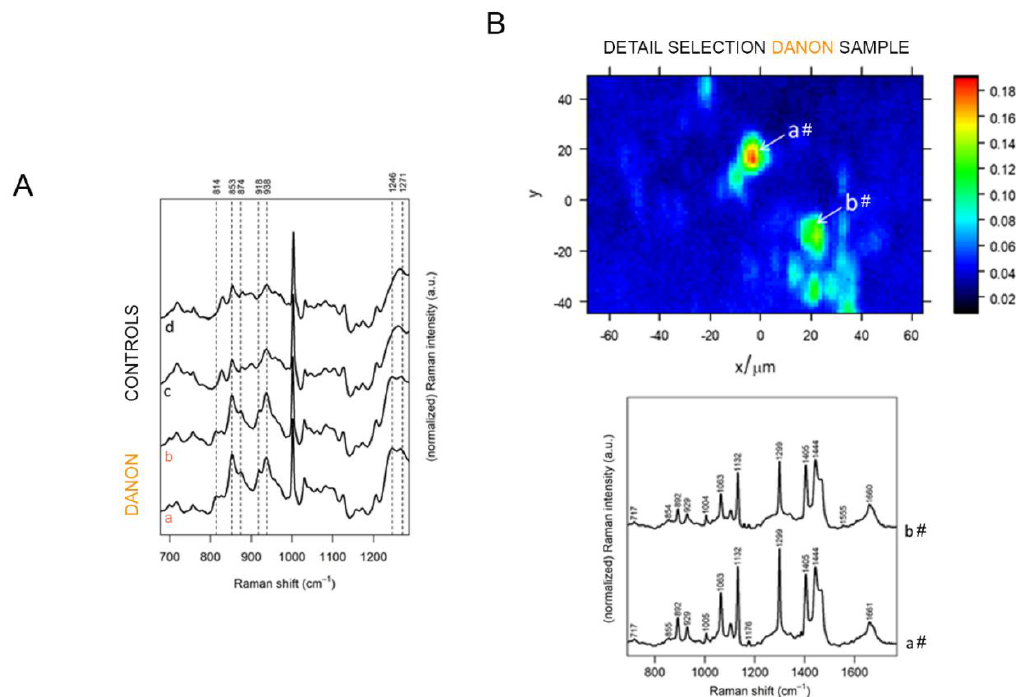
Figure 5. Structural characterization of cardiac tissue. ( A ) Average Raman spectra from tissue sections collected from two Danon patients (a, b, orange) and two controls (c, d, black). The Raman shifts of characteristic collagen bands are shown. Spectra were baseline corrected and intensity normalized with respect to the Phe band at 1002 cm − 1 . ( B ) High-resolution Raman map of a tissue section from a Danon patient and respective spectra of saturated branched fatty acids observed from two different positions (#a, #b). Spectra were baseline corrected and intensity normalized (area normalization). The map depicts the normalized intensity distribution at 1299 cm − 1 , a characteristic Raman shift for saturated lipids.